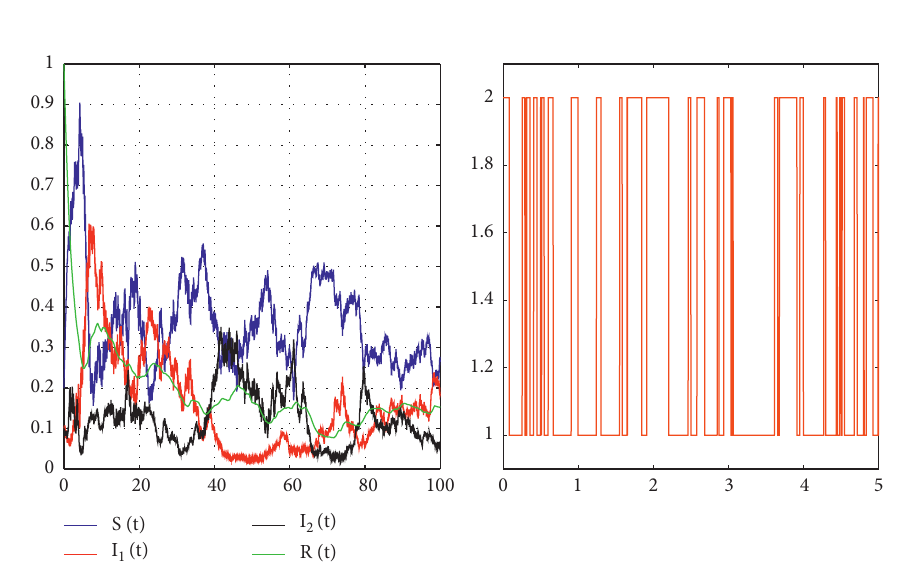
Figure 3: Sample paths of S ( t ) in blue, I